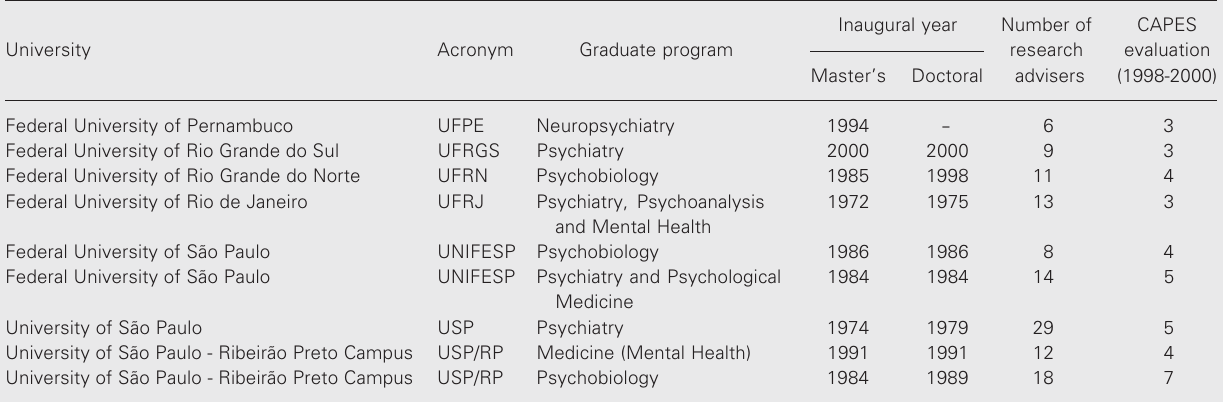
Table 1. Characteristics of Brazilian graduate programs in Psychiatry and related